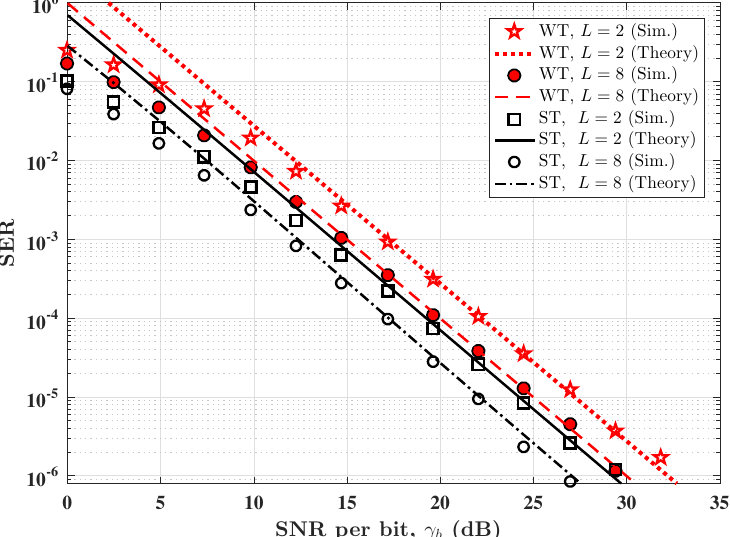
Figure 3. Error performance of SPPM in weak and strong AT conditions. N t = 4, N r = 4, and L =[ 2,8 ] .